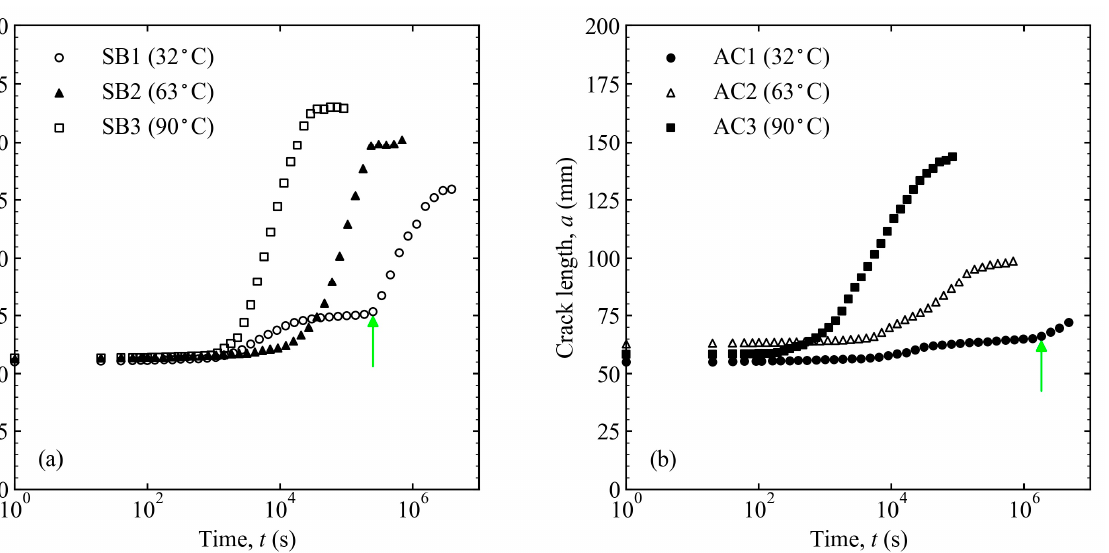
sandblasting and ( b ) pickling. The light-green arrows are the failure mode changing points, which relate